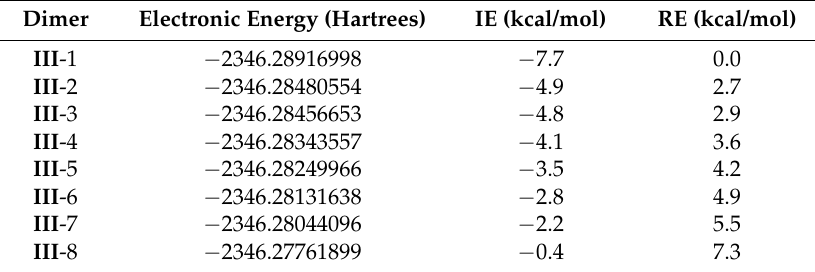
Table 6. Energetic properties of the eight dimers